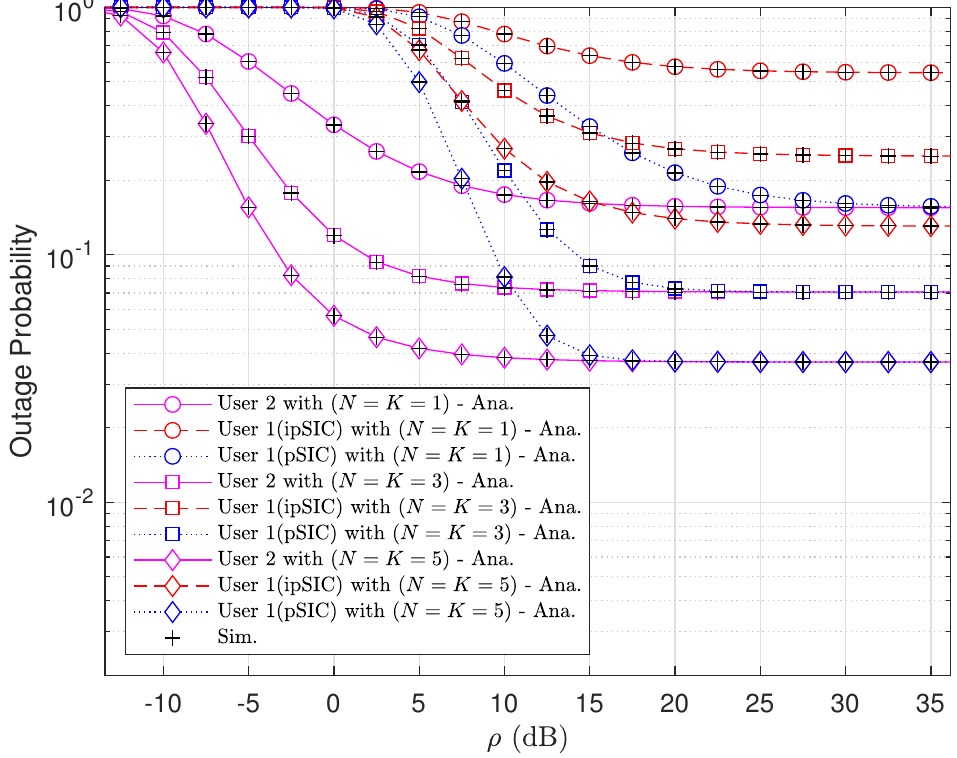
Figure 2. Outage probabilities of two vehicles versus transmit signal-to-noise ratio (SNR) with a fading parameter m =